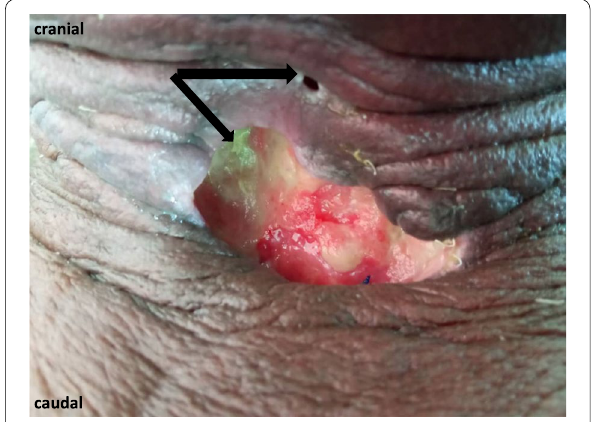
Fig. 3 Pharyngocutaneous fistula (black